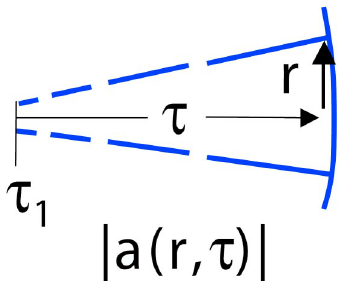
FIG. 3. (Color) Contours of constant optical field amplitude j a j as a function of Cartesian coordinates (cid:3) r; (cid:3) (cid:5) for free-space diffraction of a nearly spherical wave front, for (cid:3) dashed lines indicate the increasing size of the integration steps in the unprimed coordinate system.